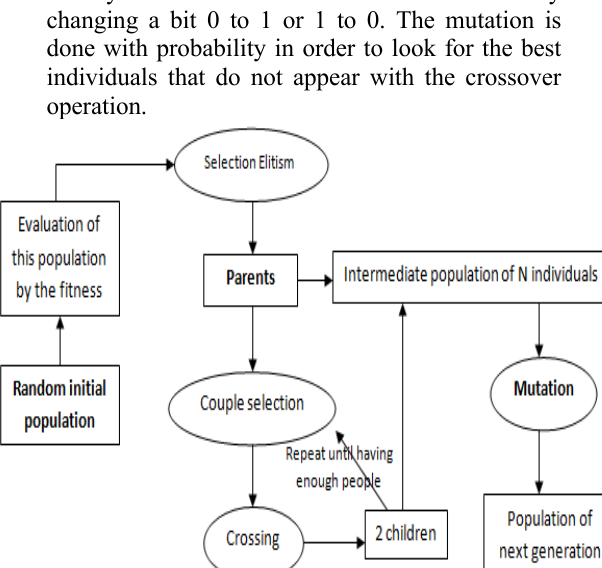
Figure 2: Structure of the Genetic